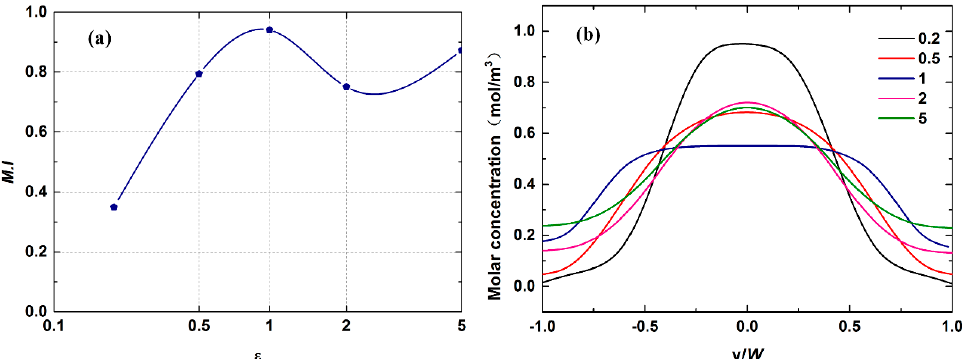
Figure 11. ( a ) The mixing indices under different aspect ratios. ( b ) The molar concentration with different aspect ratios at x = 3000 μ m.